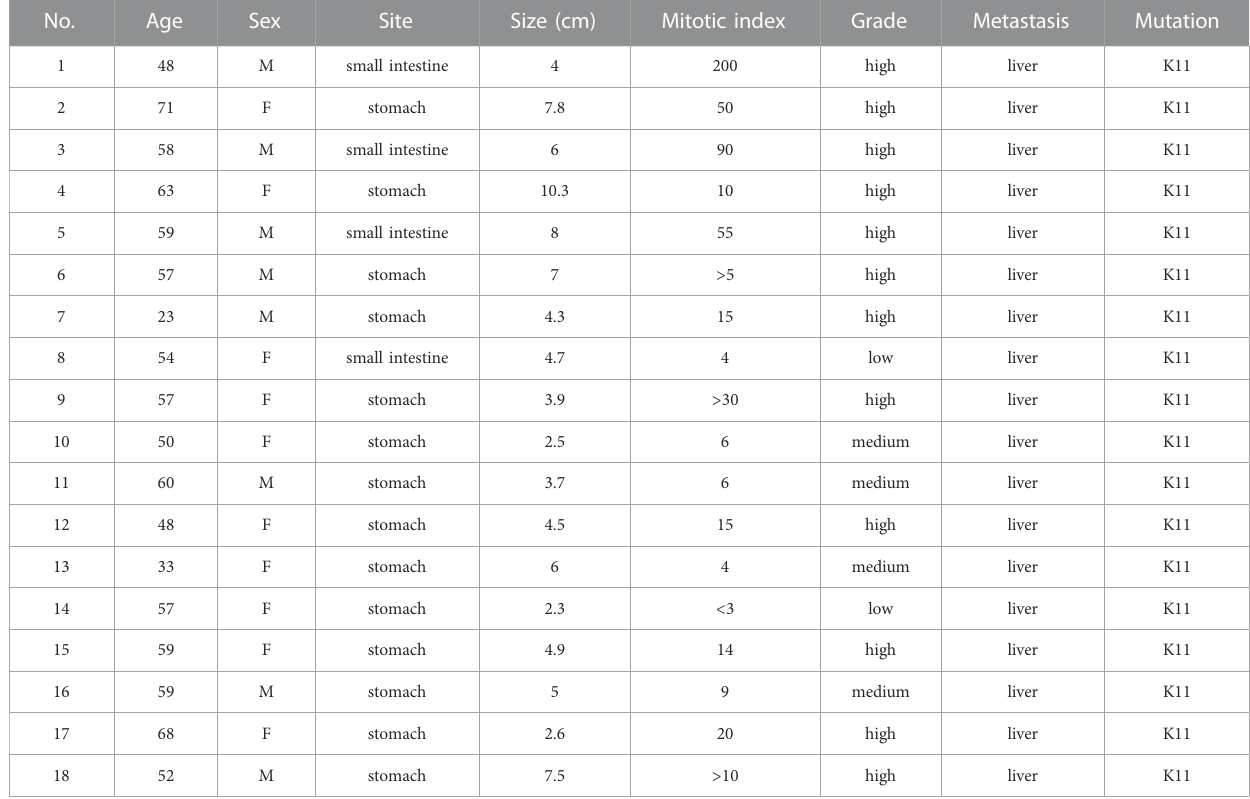
TABLE 1 Details of mutations, clinical features for the 18 GIST patients with liver metastasis.